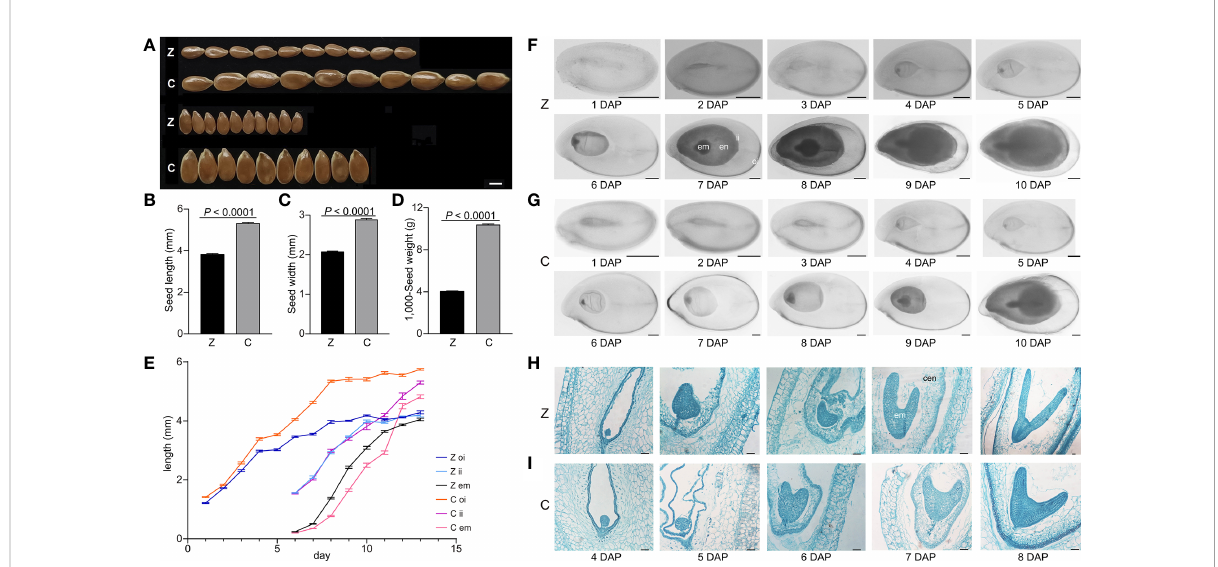
FIGURE 1 Analyses of seed development in Z and C. (A) Seed phenotypes of Z and C. (B – D) Seed length (B) , seed width (C) , and 1,000-seed weight (D) of Z and C. p -values were analyzed by two-tailed t -test. (E) Outer integument length, inner integument length, and embryo length (mm) of Z and C. (F, G) Morphology of developing fl axseed of Z (F) and C (G) . (H, I) Microscopy images of developing fl axseed of Z (H) and C (I) . Z, Z11637; C, CIli2719; oi, outer integument; ii, inner integument; en, endosperm; em, embryo; cen, cellularized endosperm. Scale bars, 2 mm (A) , 500 µm (F, G) , and 50 µm (H, I)